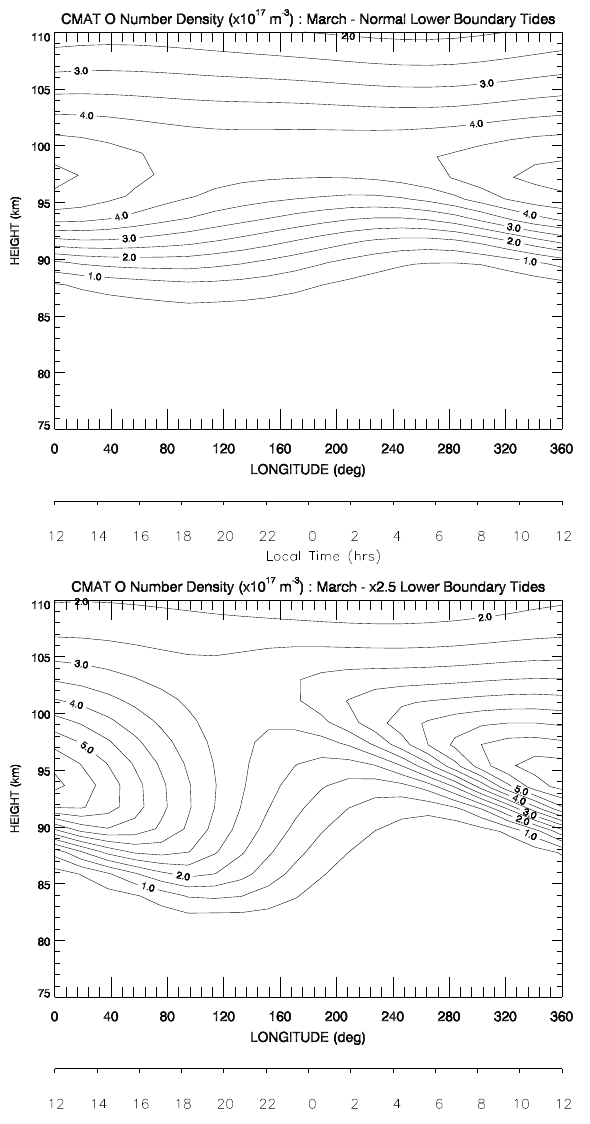
Fig. 7. Local time variation of atomic oxygen number density ( × 10 17 m − 3 ) as calculated by CMAT for 12:00LT March at the equator, with normal lower boundary tidal forcing (top), and × 2 . 5 lower boundary tidal forcing (bottom).